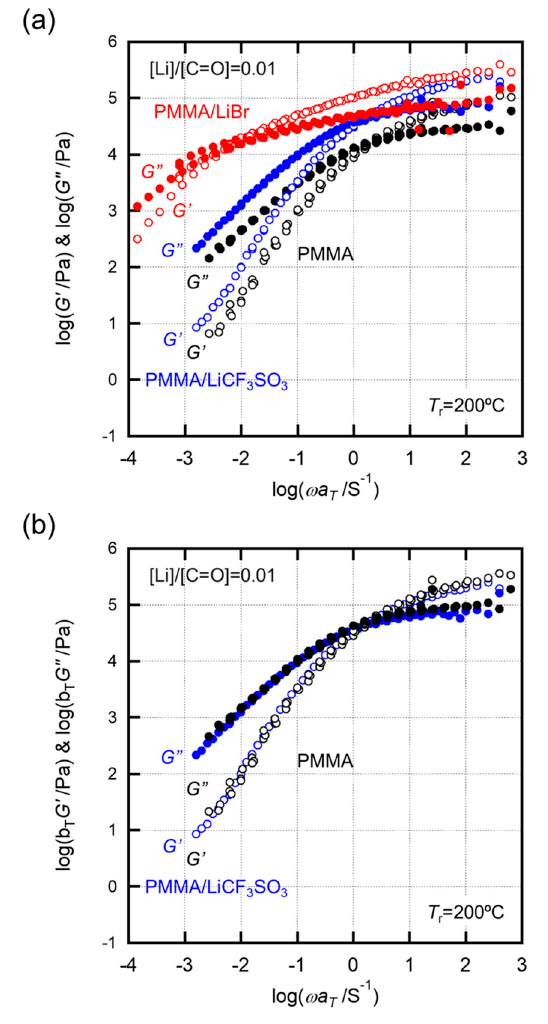
Figure 5. ( a ) Storage and loss moduli of PMMA/LiCF 3 SO 3 and PMMA/LiBr with [Li]/[C=O] = 0.01 plotted against the frequency reduced to 200 °C. ( b ) The longitudinal shift of PMMA/LiCF 3 SO 3 toward PMMA.